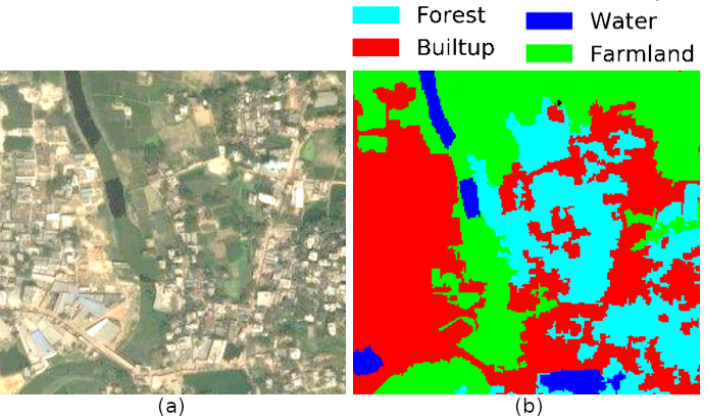
Figure 2. ( a ) Satellite image; ( b ) Land use land cover segmented